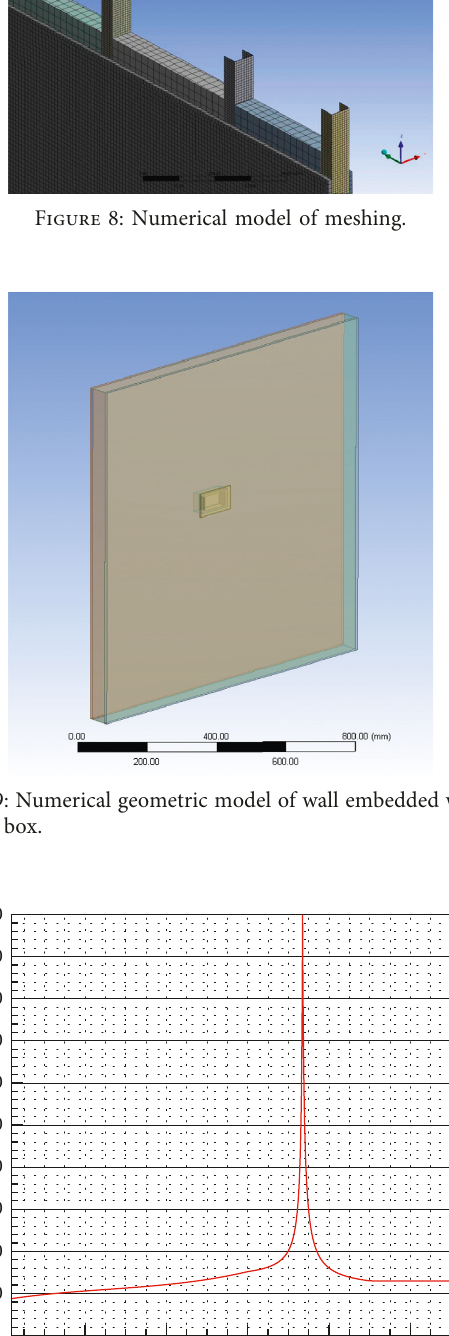
Figure 10. The thermal conductivity of steel is 53.3 W/m ° C